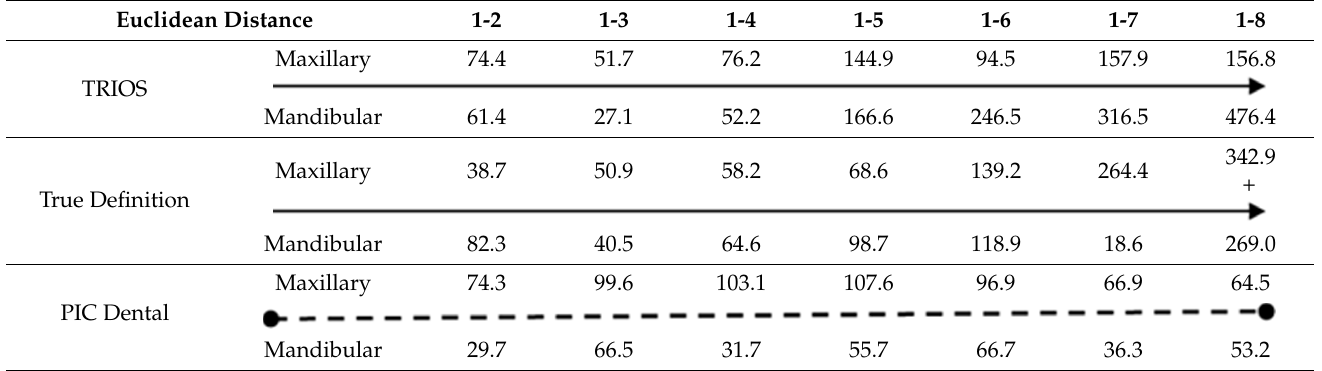
Table 4. Maximum errors of distance measurements of each IOS in each arch. Distance 1-8 was selected to represent the distance that was most affected by accumulative error.